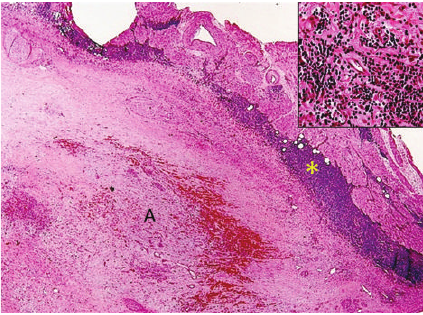
Figure 1: H&E stain. H&E stained slide demonstrating atrial myxomatissue(A)andBcelllymphoma( ∗ )anda40ximage(topleft corner) showing B cell lymphocytic infiltrates into atrial myxoma.